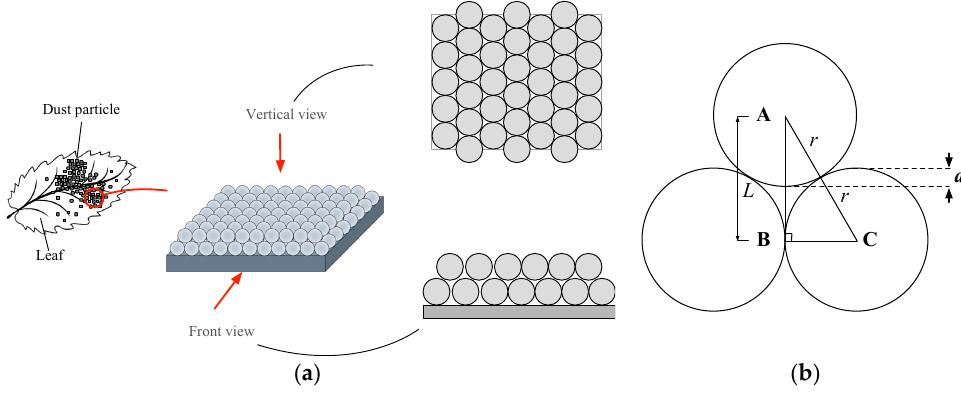
Figure 3. Particle arrangement and accumulation mode: ( a ) is the arrangement and accumulation of dust particles on the leaves. ( b ) is a schematic of the calculation of the value of a. According to the arrangement and accumulation in Figure 3a, the calculation process of a is given by Equation (8) [37].